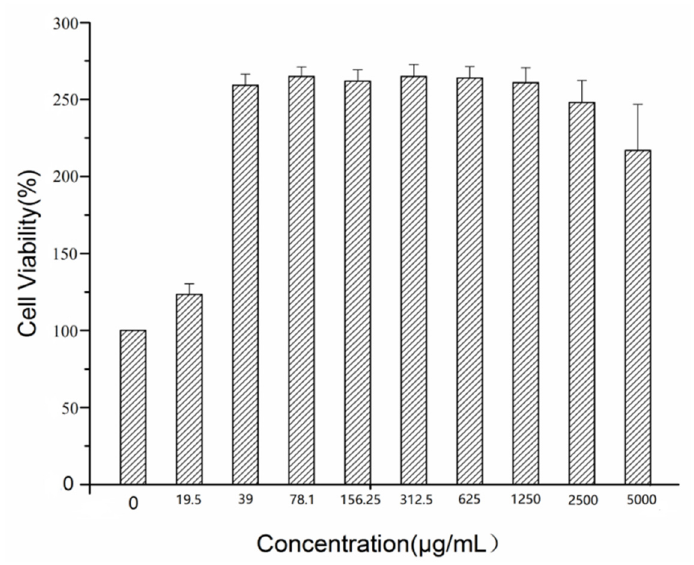
Figure 5. Effect of different concentrations of GRR-CDs on cell viability.